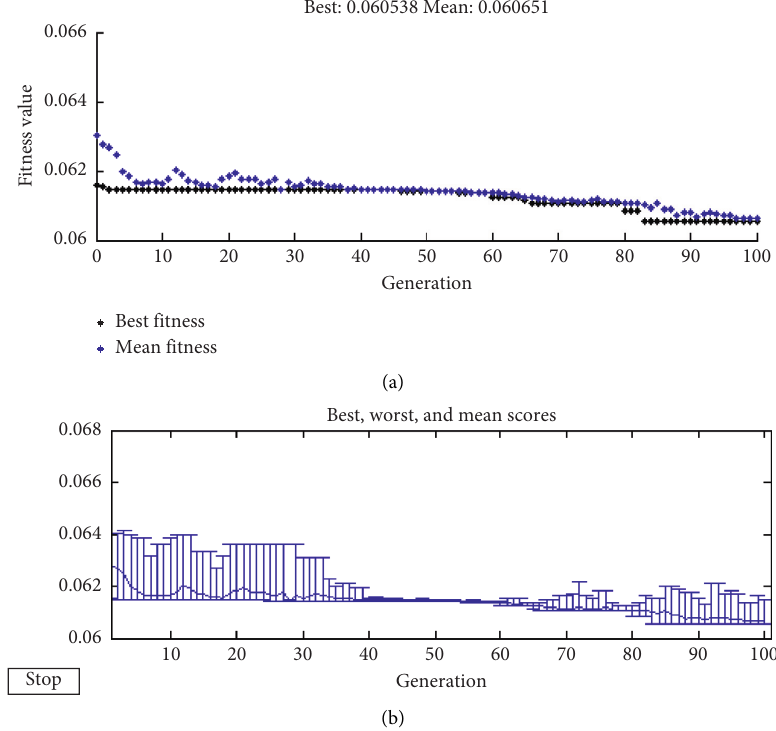
Figure 3: The convergence process of objective function by using genetic algorithm.